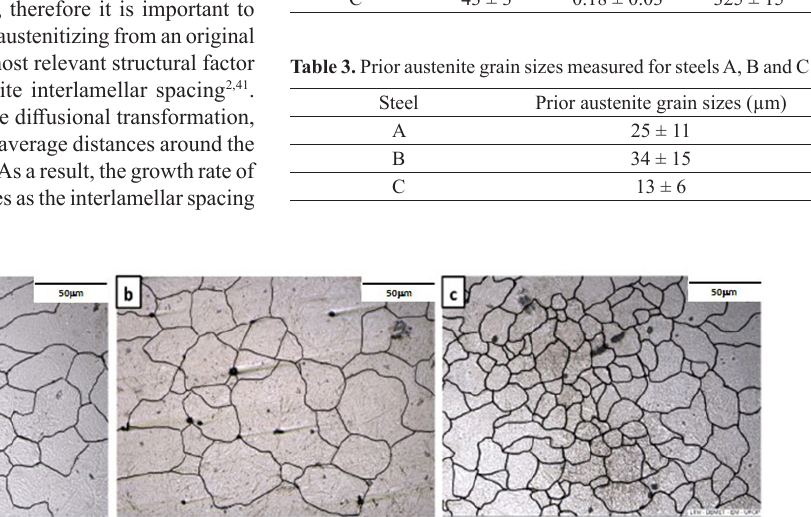
Figure 2. Prior austenite grains revealed for steels: (a) A, (b) B and (c) C - OM - 500X - Teepol etching and threshold contrast